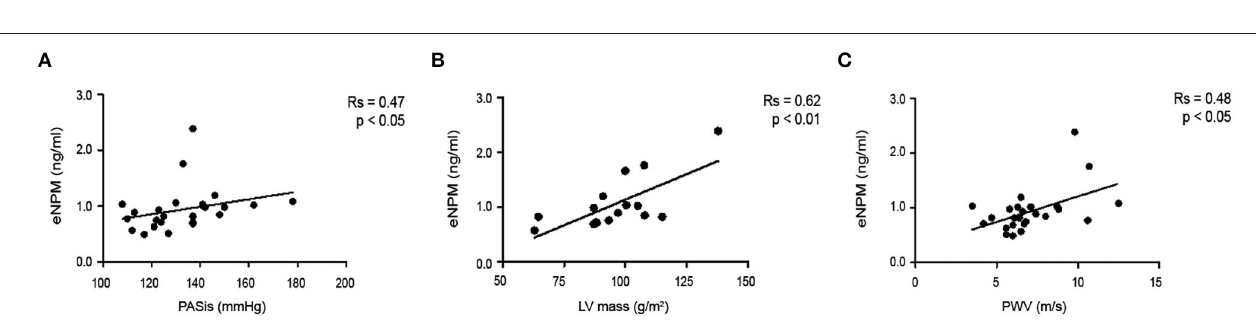
FIGURE 8 | eNPM positively correlates with determinants of CV risk. Correlation of eNPM levels with: (A) Systolic Pressure (PASis); (B) left ventricular (LV) mass index; and (C) Pulse wave velocity (PWV) (Spearman’s correlation test).